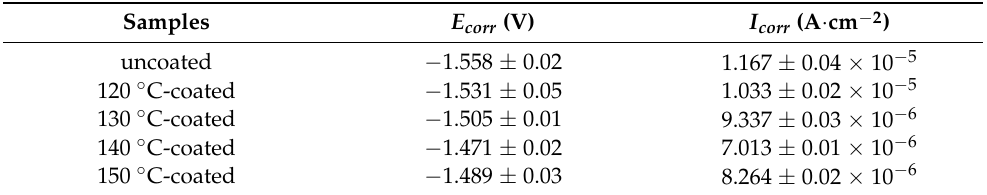
Table 3. Electrochemical parameters of the substrate and the coated samples via the potentiodynamic polarization (PP) curves.